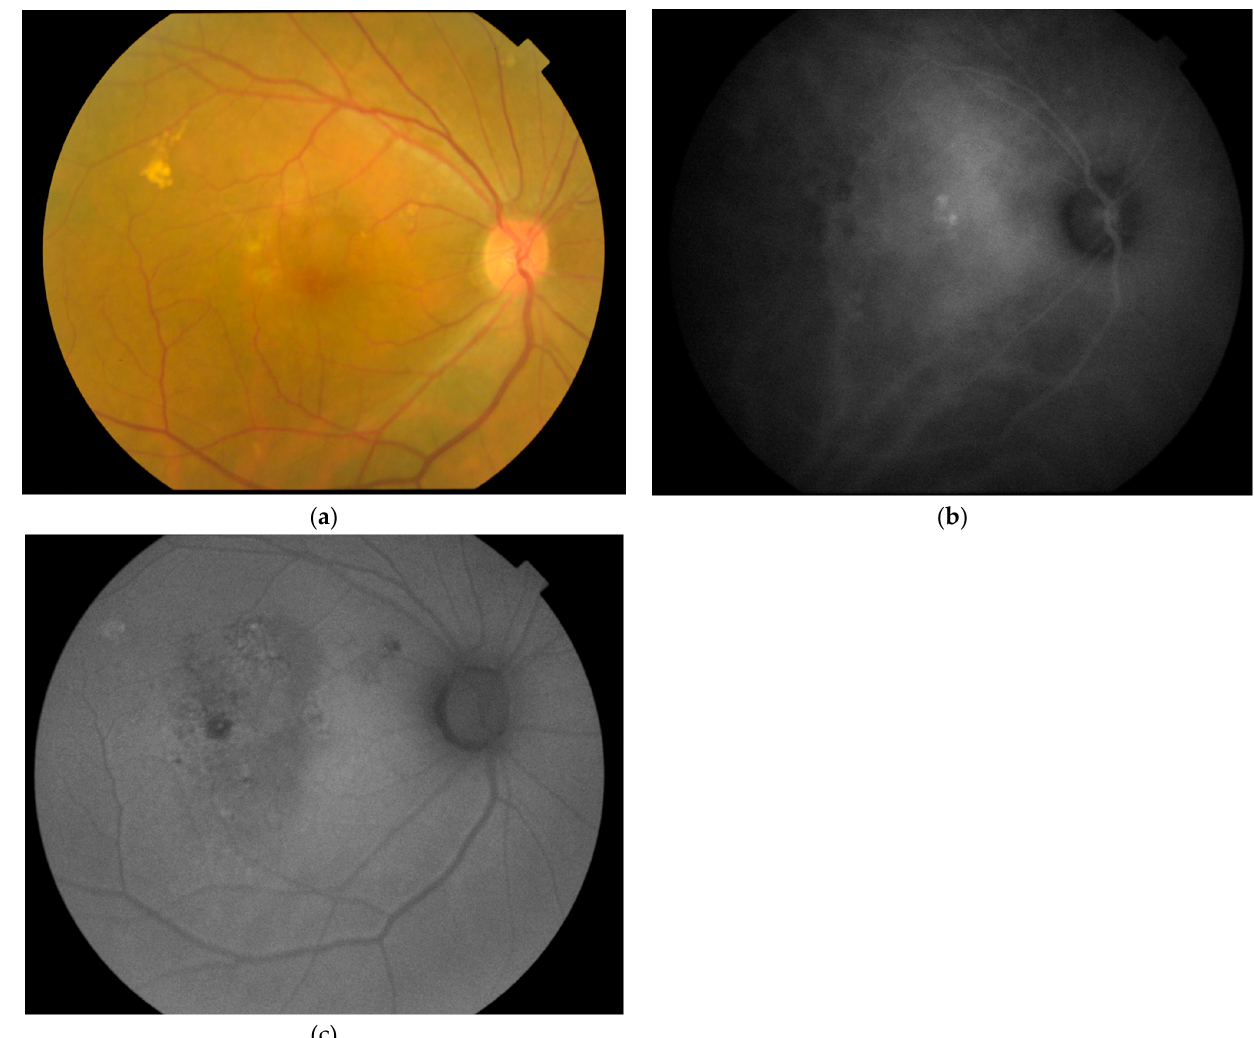
Figure 2. ( a ) Fundus photo of a 65-year-old patients with polypoidal choroidal vasculopathy showing multiple pachydrusen occurring as a cluster in the superiotemporal macula with a few small isolated drusen in the superionasal retina; ( b ) indocyanine green angiography showing multiple polypoidal lesions at the macula with dilated choroidal vasculature and choroidal hyperpermeability; ( c ) fundus autofluorescence showing mixed autofluorescence abnormalities with increase and reduced autofluorescence of ≥ 2 disc areas scattered in the central macula with a ring of increased autofluorescence highlighting the polypoidal lesions. Table 2. Characteristics of PCV eyes with or without pachydrusen.